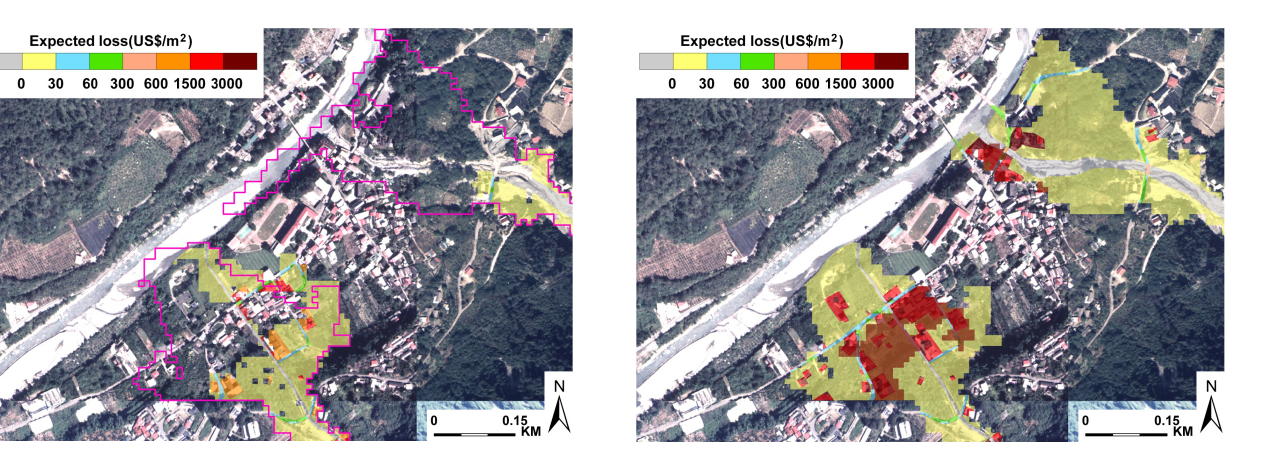
Fig. 9. Map showing the maximum expected total loss caused by debris flows of the Nos. 1 and 2 Torrents for an event with 50-year return period when the delimitation strategy was not conducted.